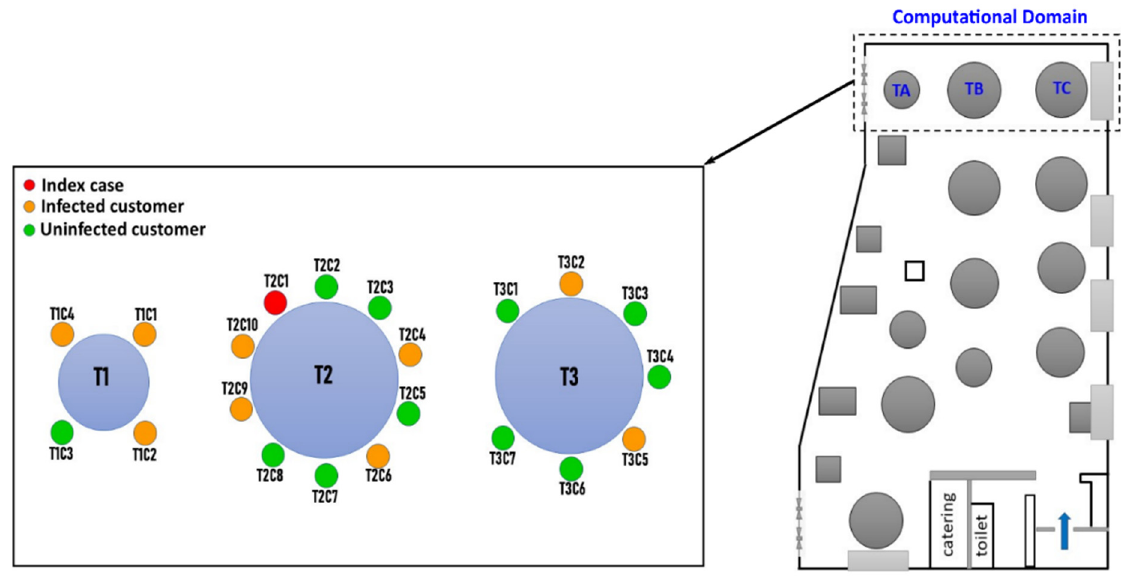
Figure 1. Sketch of locations of tables and the number of customers sitting around each